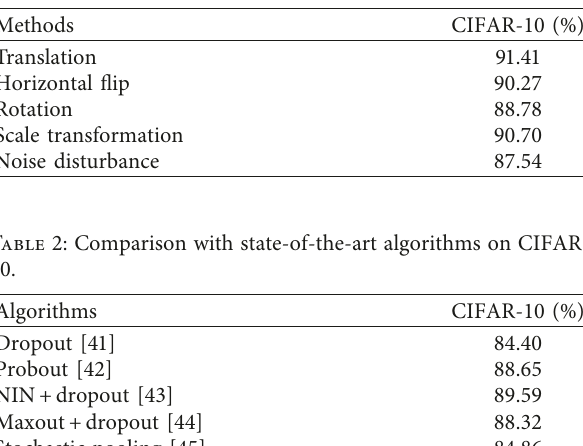
Figure 6: Classification results on CIFAR-10 before and after using full stage data augmentation method. (a)–(d) represent “no data augmentation,” “augmentation in training stage,” “augmentation in test stage,” and “full stage data augmentation,” respectively. Table 1: Classification accuracy of various data augmentation methods on CIAFR-10 under the proposed full stage data aug- mentation framework.